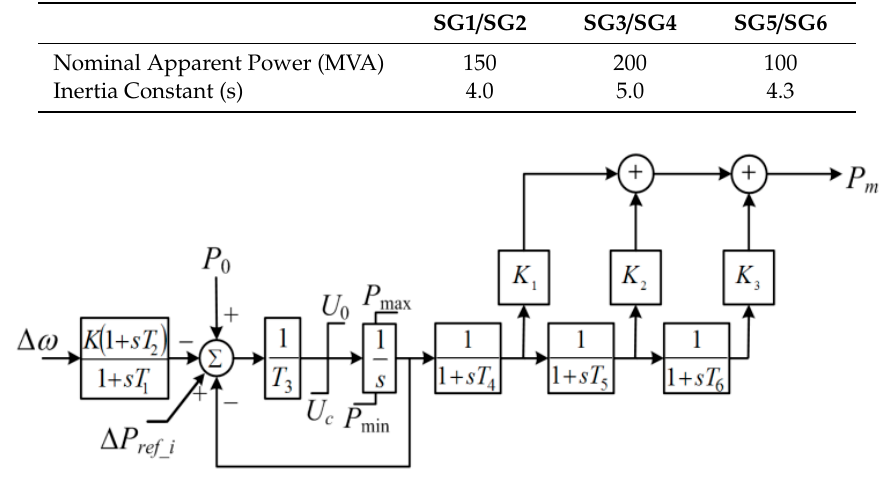
Table 3. Parameters of the